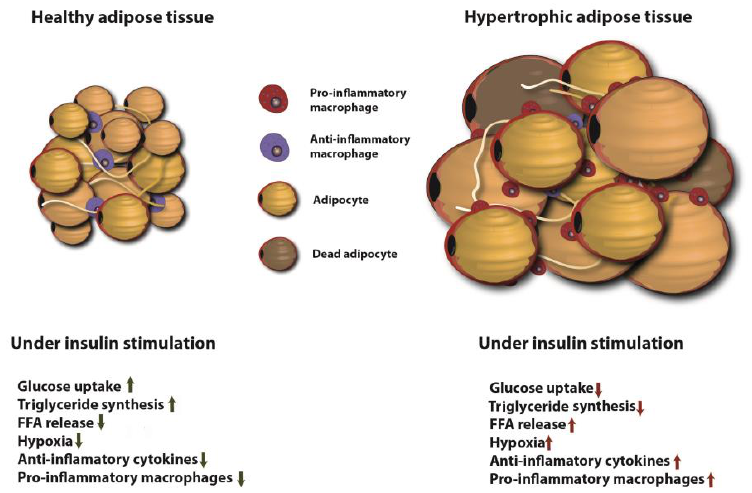
Figure 4. Insulin stimulation effects on healthy and hypertrophic adipose tissue. In healthy adipose